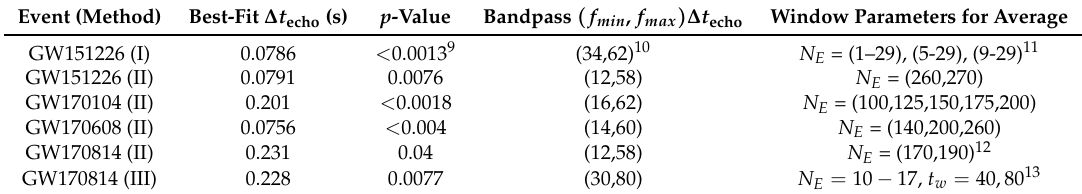
Table 9. The best-fit ∆ t echo , p -value, bandpass and window parameters for the six signals [21]. Here N E is the number of frequency steps between spikes which has been chosen using injection and echoes model properties in [21].